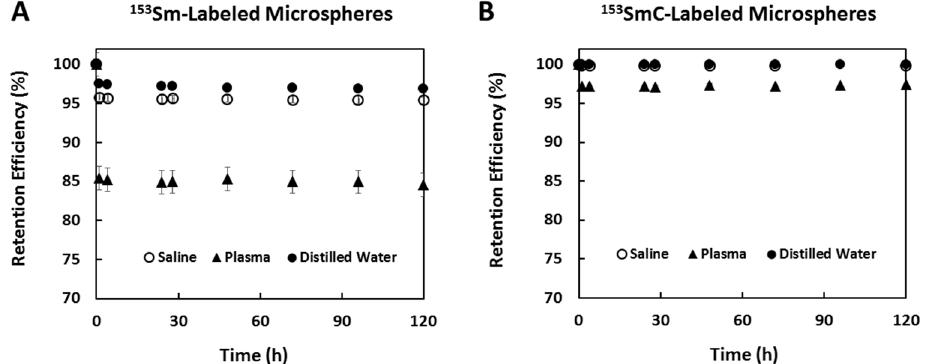
Figure 8. Retention (%) of 153 Sm in 153 Sm- ( A ) and 153 SmC-labeled ( B ) microspheres suspended in distilled water, saline, and human blood plasma over 120 h.